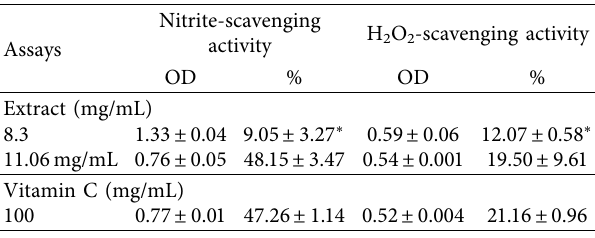
Table 1: Radical scavenging activity of crude polysaccharides of T. le-testui as measured by the nitrite and H 2 O 2 -scavenging tests and compared to standards (vitamin